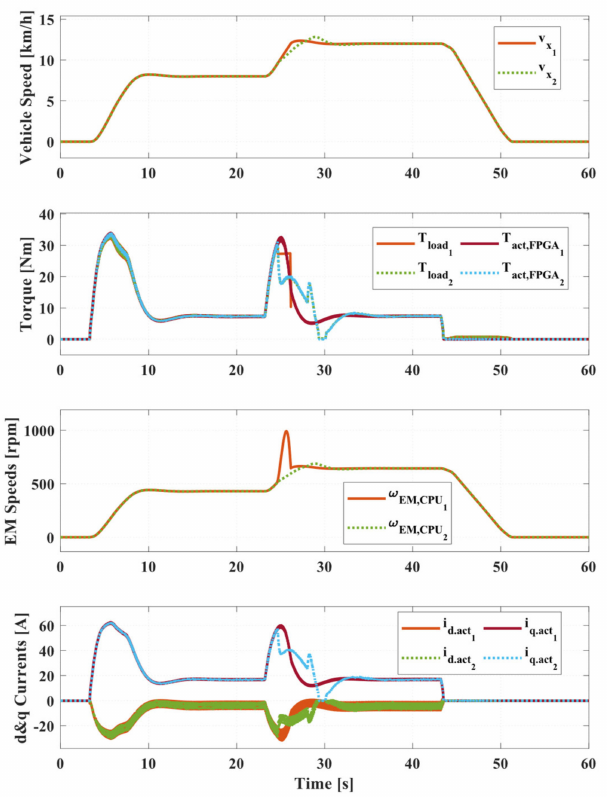
Figure 12. Anti-slip real-time simulation results. Subscripts “1” and “2” indicate without and with anti-slip function,